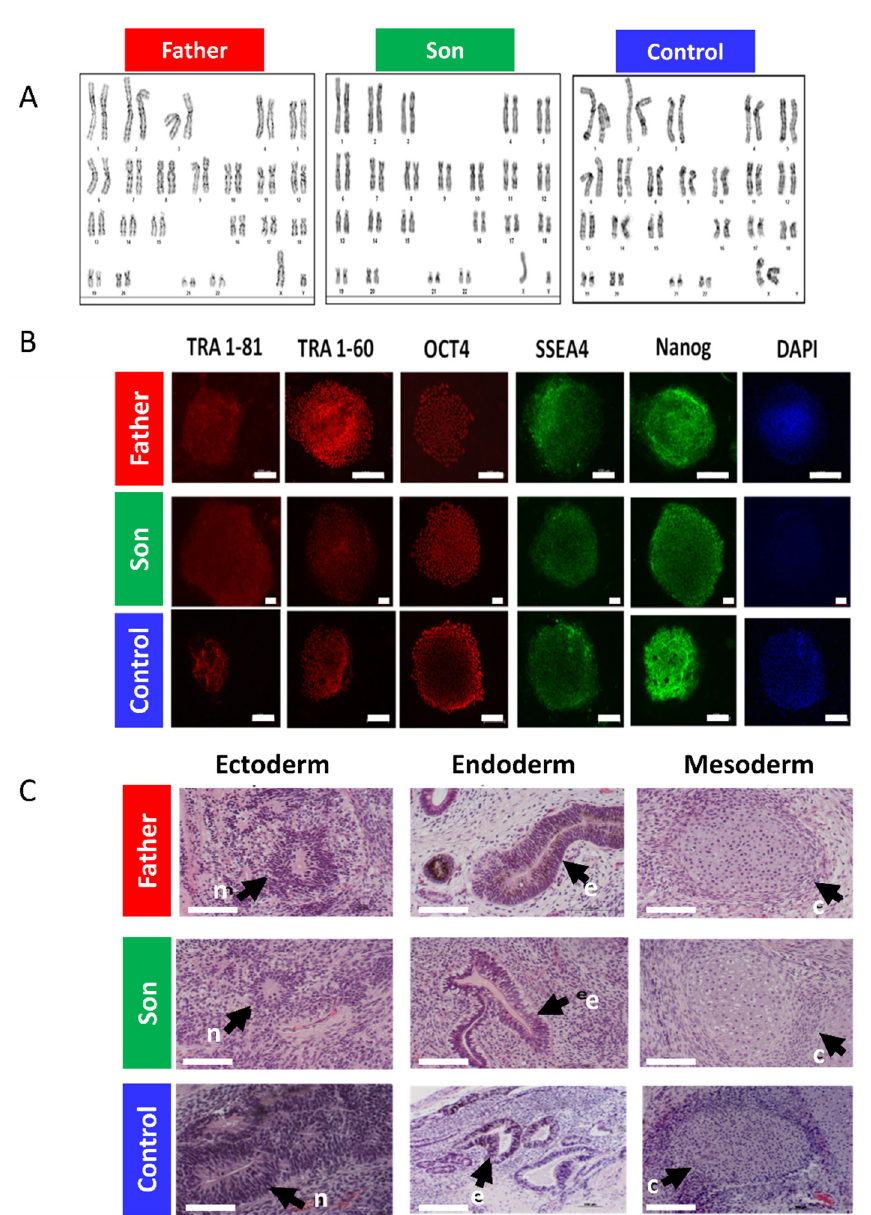
Figure 2. The LMNA -mutated patients iPSCs characteristics. ( A ) Father, son and control iPSCs showing normal karyotype. ( B ) Pluripotency staining of LMNA -mutated and control iPSCs. Immunofluorescence staining of typical pluripotent mark- ers Tra1-81 (red), Tra1-60 (red), Oct4 (red), SSEA4 (green) and Nanog (green) in iPSCs generated from father, son and control. Nuclei are stained with DAPI (blue). Scale bar represents 100 µm. ( C ) Teratoma histological analysis obtained from in vivo differentiated LMNA -mutated and control iPSCs. Teratomas were obtained from SCID-NOD mice injected with either father, son or control iPSCs which differentiated in vivo into derivatives of all three germ layers: ectoderm, endoderm and mesoderm. n—Neuronal tissue represents ectodermal lineage. e—Endodermal epithelium with prominent mucus-producing cells representing endoderm formation. c—Cartilage as well as the chondrocyte area and muscle repre- senting mesoderm formation. Scale bar represents 100